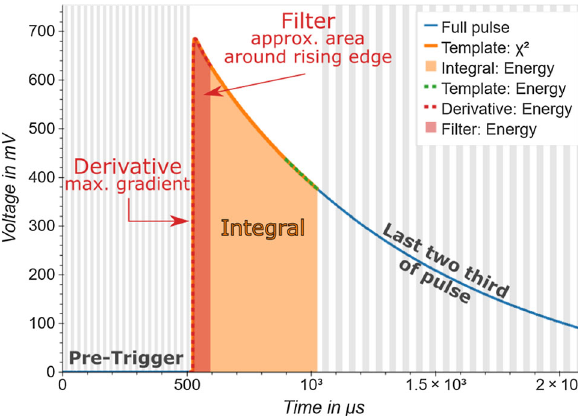
Fig. 8 The parts of the time signal used in the different analysis meth- ods are indicated in different colors. A template pulse is shown in blue. The first third after the pre-trigger (orange line) is fitted to all pulses in order to obtain the reduced χ 2 . In addition the tail of this part of the template (the last quarter, green dotted) is fitted to all pulses to obtain the amplitude of the fit to increase the sensitivity to pile-up occurring in the first third of the pulses. The first part of template around the ris- ing edge (red dotted line) is convoluted with each pulse, which mainly results in the area under the pulse around the rising edge (red area). The derivative of the smoothed pulses are calculated to obtain the max- imum gradient. The area under the pulses (orange area) are calculated to identify pile-up pulses given by the reduced χ 2 (i.e. χ 2 dof − 1 ) and is